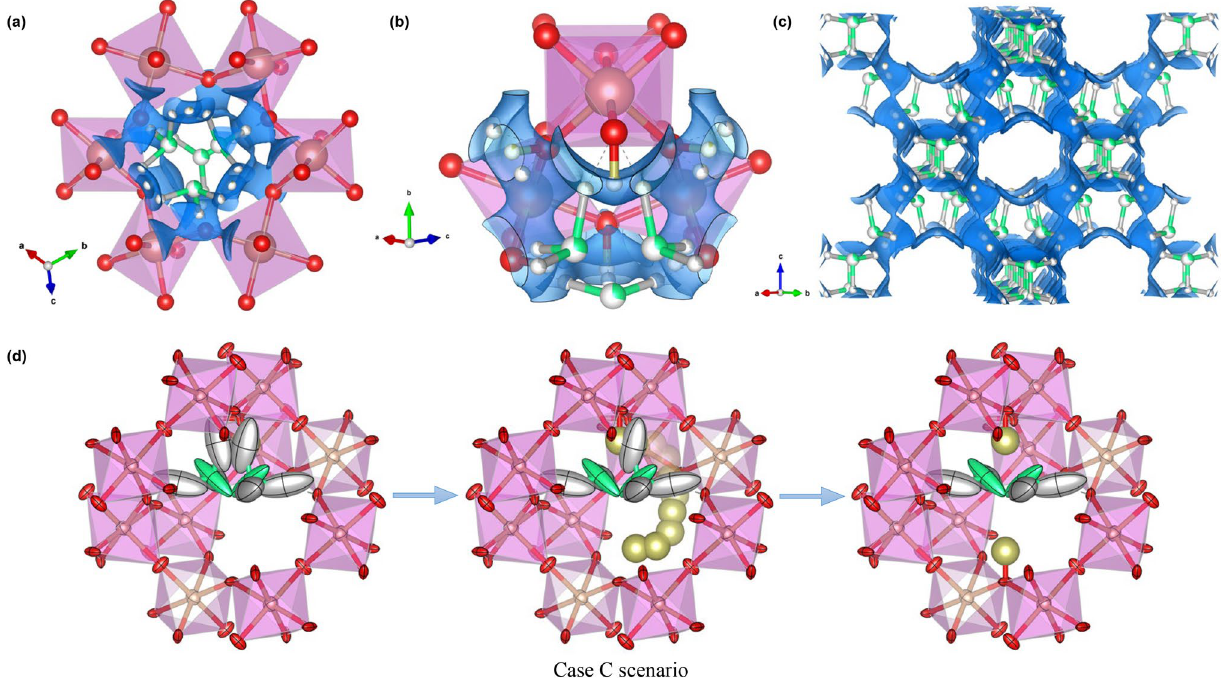
Figure 2. Proton percolation pathway and mechanism in the AA (‘Case C’ scenario described in the Supplementary Information). Atoms in all six panels are presented as anisotropic displacement ellipsoids at a 95% probability level. The colour reference is the same one used in Fig. 1. ( a , b ) Close up of the AA final structure; the ionic percolation path is highlighted in blue. The pathway involves both H + species in a 3D interconnected arrangement, generating the 3D percolation isosurface defined for the AA. The ionic percolation begins with a low percolation activation energy barrier of 0.13 eV. ( c ) Proton percolation pathway in a simplified view of the AA unit cell approximately along the [ 110 ] direction. For the sake of clarity, the Sb 2 O 6 2− octahedra-sharing covalent framework is hidden, and only the H 3 O + acid groups and the H2 species are visible. Statistically, less than a third of the hydronium units here figured are present. ( d ) Proposed ionic migration mechanism of two H1 atoms from 96 g to 48 f (H2) Wyckoff sites, for those cages wherein two H 3 O +